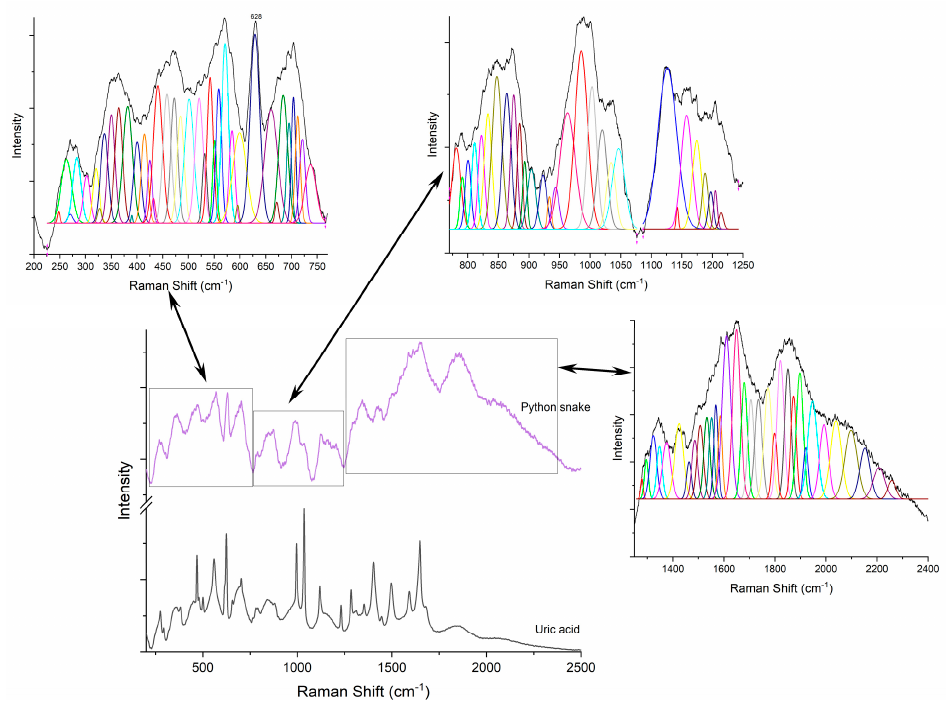
Figure 6. Raman spectra of pure uric acid and, respectively, Python snake sample.